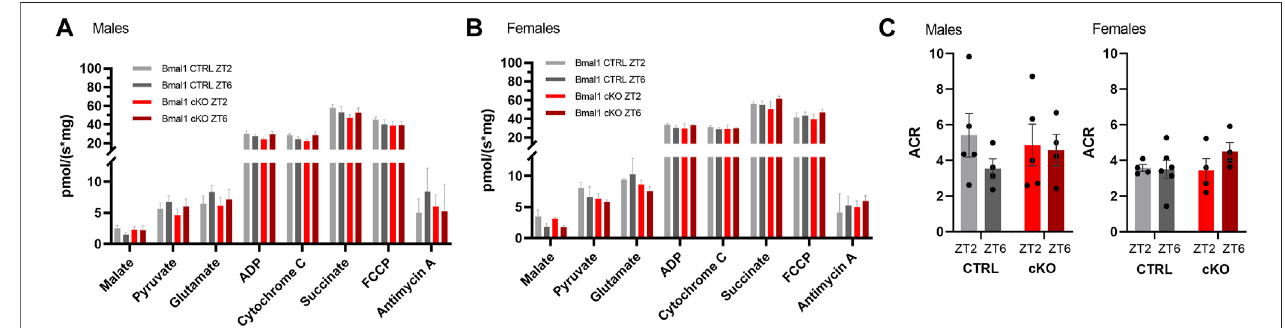
FIGURE 5 | Striatal mitochondrial respiration in mice with a conditional knockout of Bmal1 and control animals. Sequential substrate addition to assess mitochondrial coupled and uncoupled oxygen consumption, as well as leak and membrane integrity, revealed no differences between male and female mice with a conditional Bmal1 knockoutandcontrols(n=4 – 6pergenotype, sex,andtimepoint) (A,B) .Likewise,thedegreeofcouplingbetweenoxidationandphosphorylationdid notdifferbetweengenotypeswithinthe Bmal1 mouseline (C) .Resultsaredepictedasmean±standarderrorofthemean(S.E.M.).Detailsofthestatisticalanalysis are displayed in Table 3